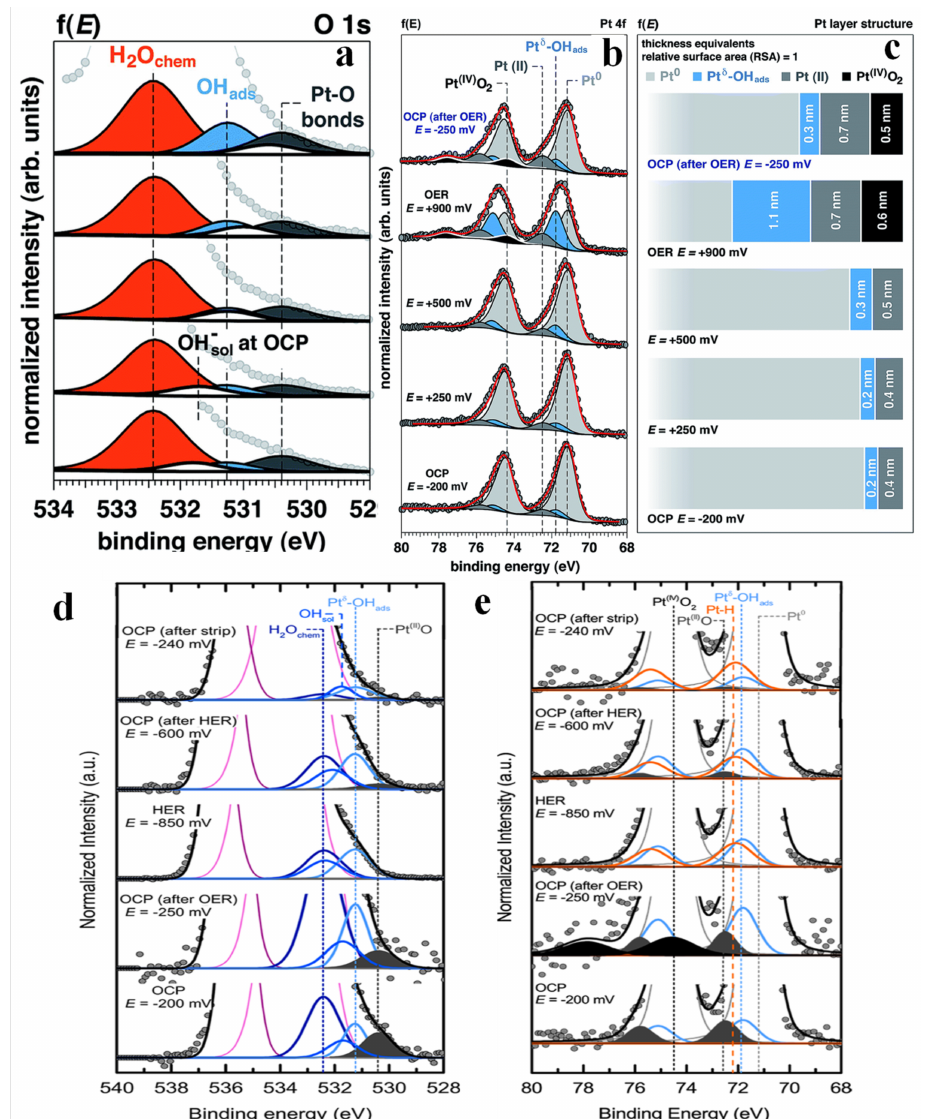
Figure 10. Operando APXPS as a function of the applied potential. The magnification of the low binding energy spectrum tail of O 1s photoelectron peak acquired at 4 keV as a function of the applied potential (f(E)) to the working electrode (WE, from OCP to OER) ( a ). Evolution of the surface chemistry studied by operando APXPS, as a function of the applied potential. Pt 4f spectra acquired at 4 keV as a function of the applied potential (f(E)) to the working electrode (from OCP to OER) ( b ). Evolution of the surface structure as a function of the applied potential (f(E)), from OCP to OER ( c ). Adapted with permission from ref. [135]. Copyright 2017 The Royal Society of Chemistry. Magnification of the O 1s, background subtracted and normalized to the intensity of the Pt 0 , as a function of applied potential, illustrating the changing surface species ( d ). Operando APXPS Pt 4f photoelectron peak at 4 keV as a function of applied potential ( e ). Adapted with permission from ref. [136]. Copyright 2018 American Chemical